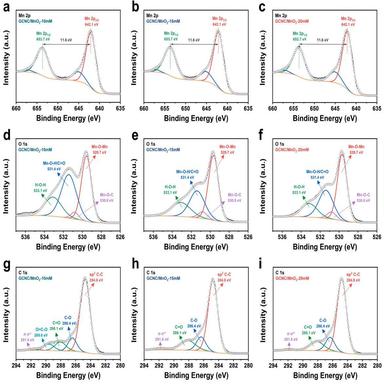
(a–c) High-resolution Mn 2p spectra, (d–f) high-resolution O 1s spectra, and (g–i) high-resolution C 1s spectra of CNC/MnO2-10 mM, GCNC/MnO2-15 mM, and GCNC/MnO2-20 mM.